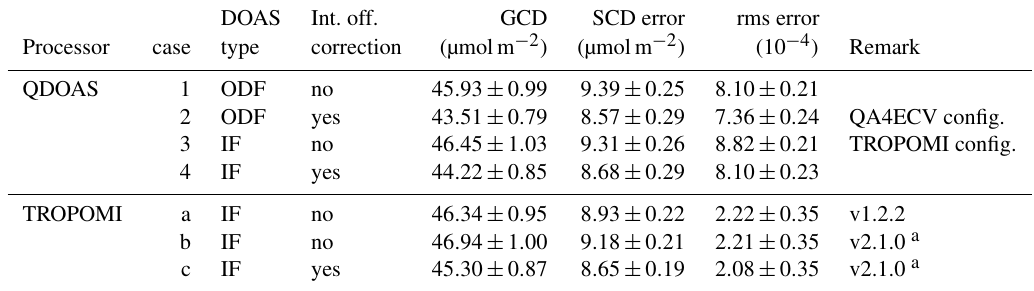
Table 2. NO 2 geometric column density (GCD), slant column density (SCD) error and rms error from the DOAS fit averaged over the TL range and the central 150 detector rows of TROPOMI Pacific orbit 03711 of 1 July 2018 retrieved with QDOAS using different settings. For comparison, the regular v1.2.2 TROPOMI results (used in this study) and a local reprocessing using the forthcoming v2.1.0 are also listed. Given the difference in rms error definitions, their values from QDOAS and TROPOMI retrievals cannot be compared directly (Sect. 3.3). DOAS Int. off. GCD SCD